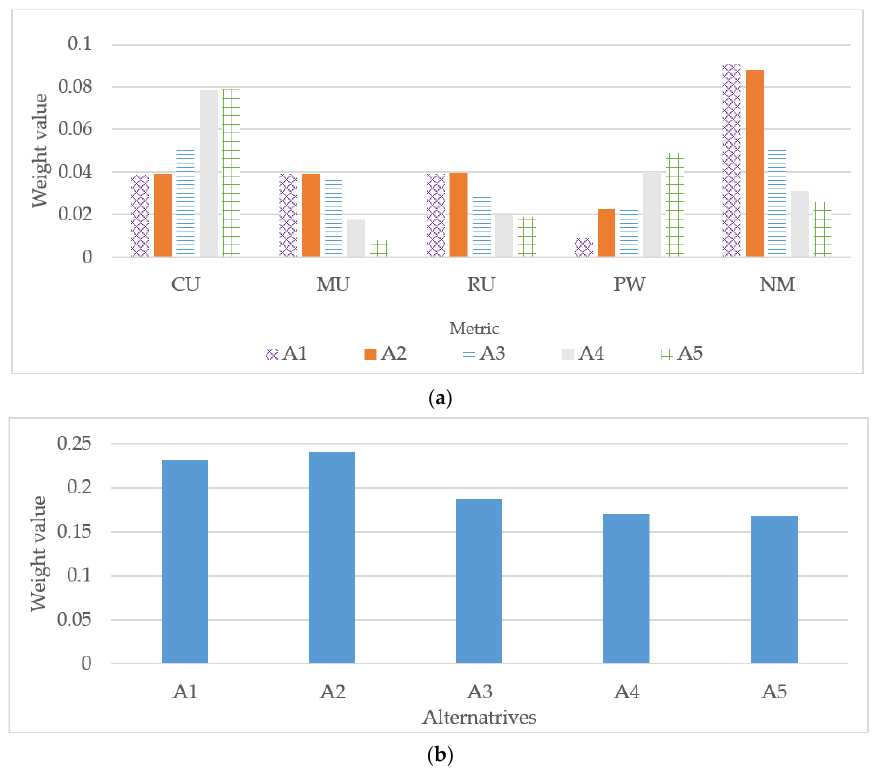
Figure 14. Alternatives for case 2: ( a ) weight value and ( b ) alternative score.